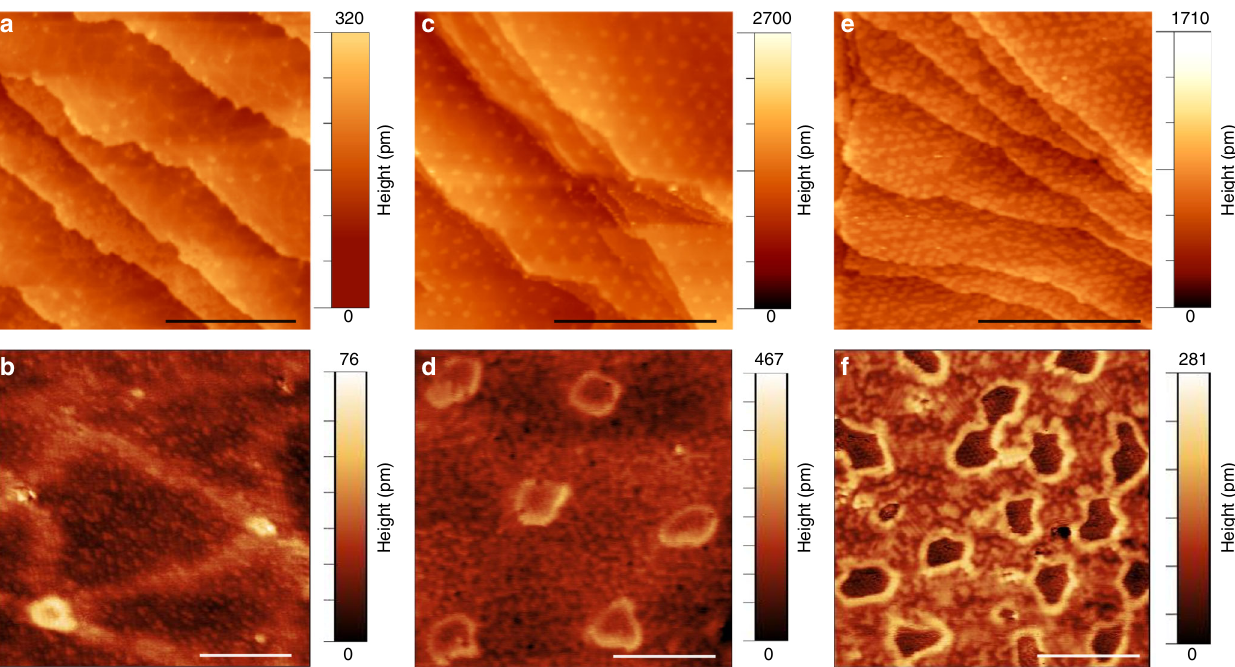
Fig. 1 Self-assembled graphene dot arrays in a BCN matrix. a , b Topographic constant-current STM images of Ir(111) surface covered with a BCN monolayer prepared by co-dosing 31.5 L of borazine (B 3 N 3 H 6 ) and 13.5 L of ethylene (C 2 H 4 ). BCN domains are surrounded by bright-contrast triangular lines of C-rich regions in a brick-and-mortar pattern. c , d As C fraction increases (22.5 L of borazine and 22.5L of ethylene), graphene nanodots of highly uniform size self-assemble and form a 2D superlattice within the host BCN matrix. e , f As C content increases further (31.5 L of ethylene and 13.5 L of borazine), the dot arrays become denser. The bright rim visible in Fig. 1d, f at the edge of the dots presumably corresponds to the boundary between the dot and the BCN domain. The scale bars are 50 nm in a , c , e , 5 nm in b , d , f . ( Imaging parameters : a 0.5 V and 0.8 nA; b 0.8 V and 0.2 nA; c − 1.2 V and 0.9 nA; d − 0.7 V and 0.3 nA; e 0.3 V and 0.2 nA; f 0.5 V and 0.4